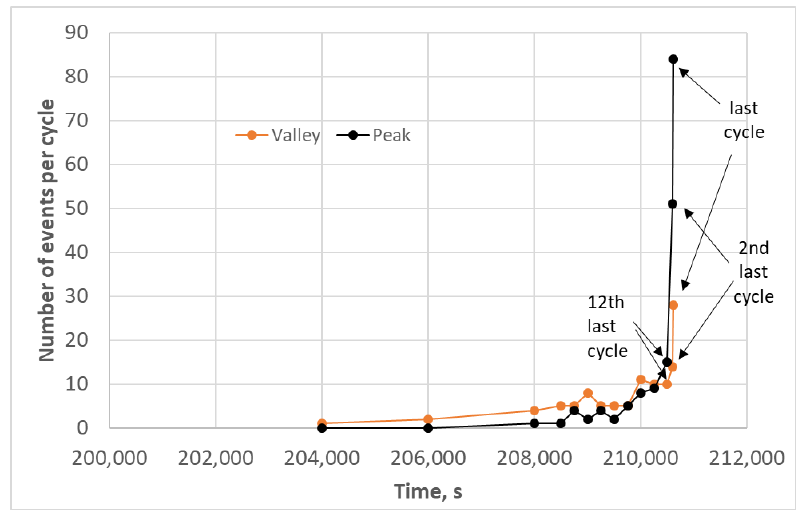
Figure 5. Number of events per cycle for peak and valley events for 113-3 at the end of the test.